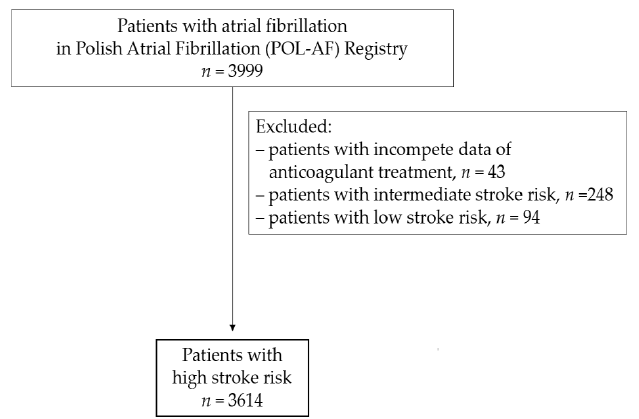
Figure 1. Study flow